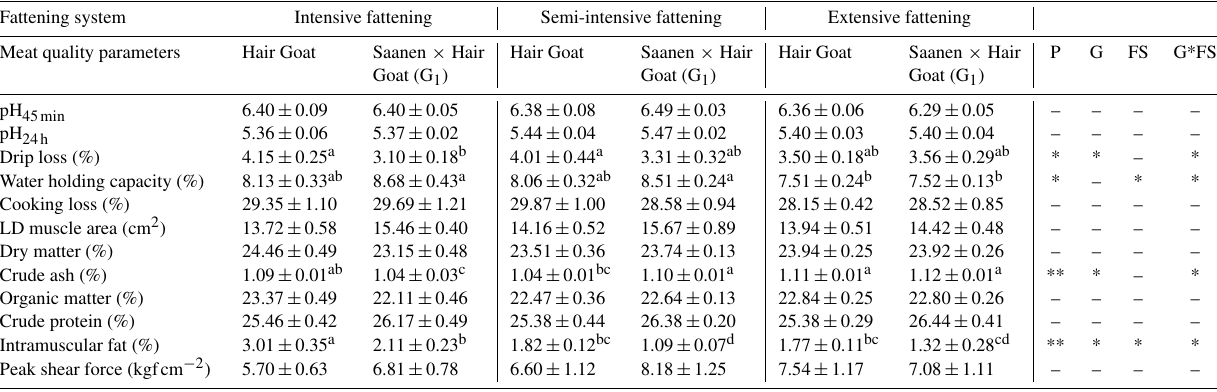
Table 2. Meat quality traits of Hair Goat and Saanen × Hair Goat (G 1 ) crossbred kids.